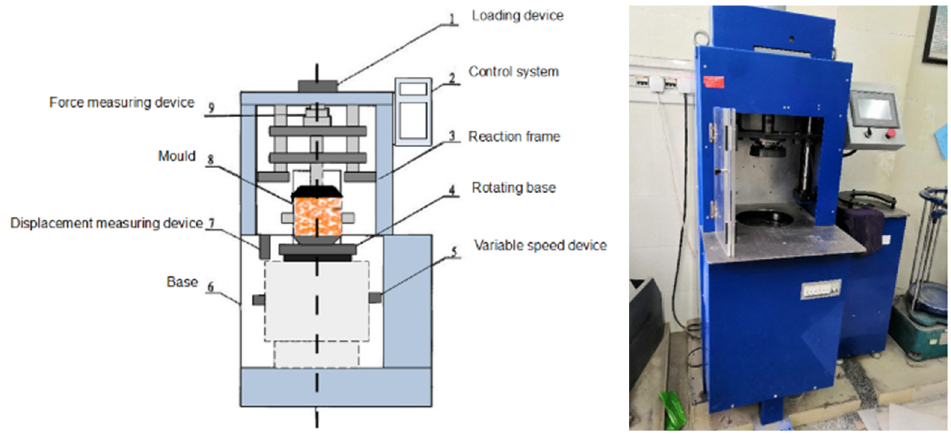
Figure 3. Illustration of different components of the gyratory compactor used.